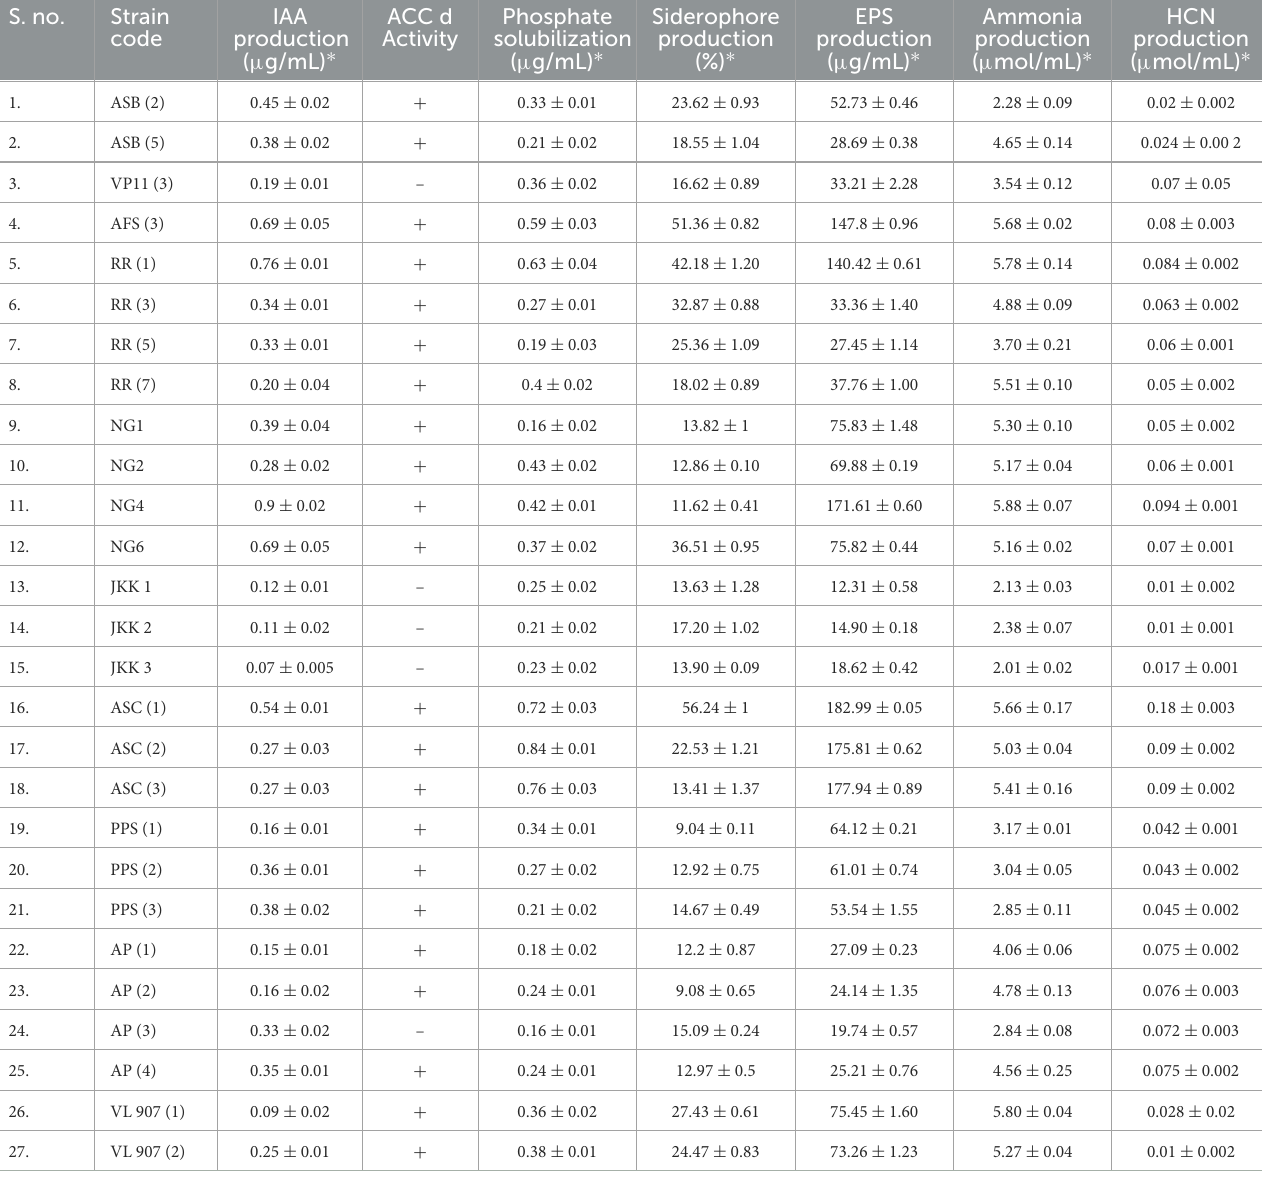
TABLE 2 Screening of isolated rhizobacteria for various direct and indirect plant growth-promoting traits. S.